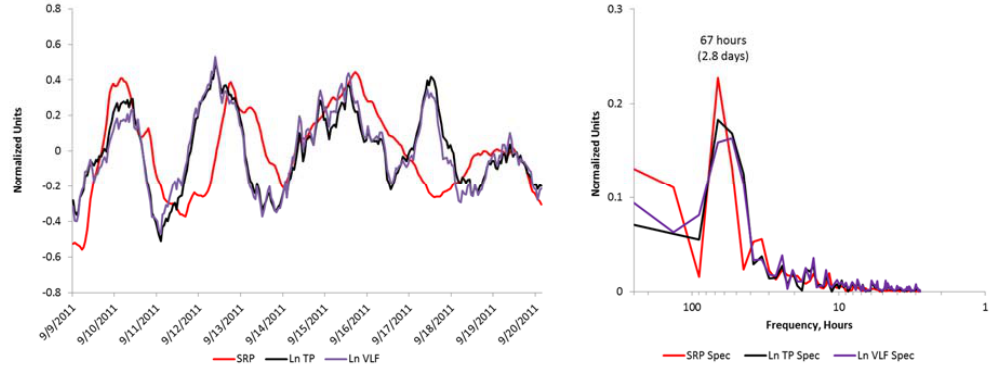
Figure 3. Overlay chart and frequency spectrum of the Schumann resonance power and the HRV metrics Total and VLF